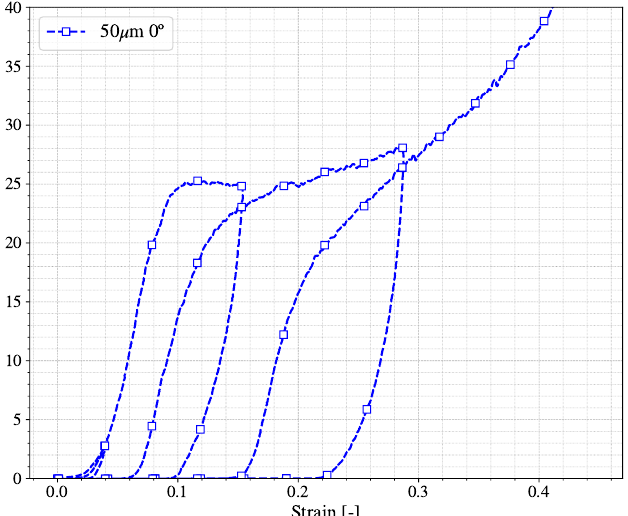
Figure 7. Loading and unloading compression behavior in True stress vs. true strain for a 0 ◦ printed